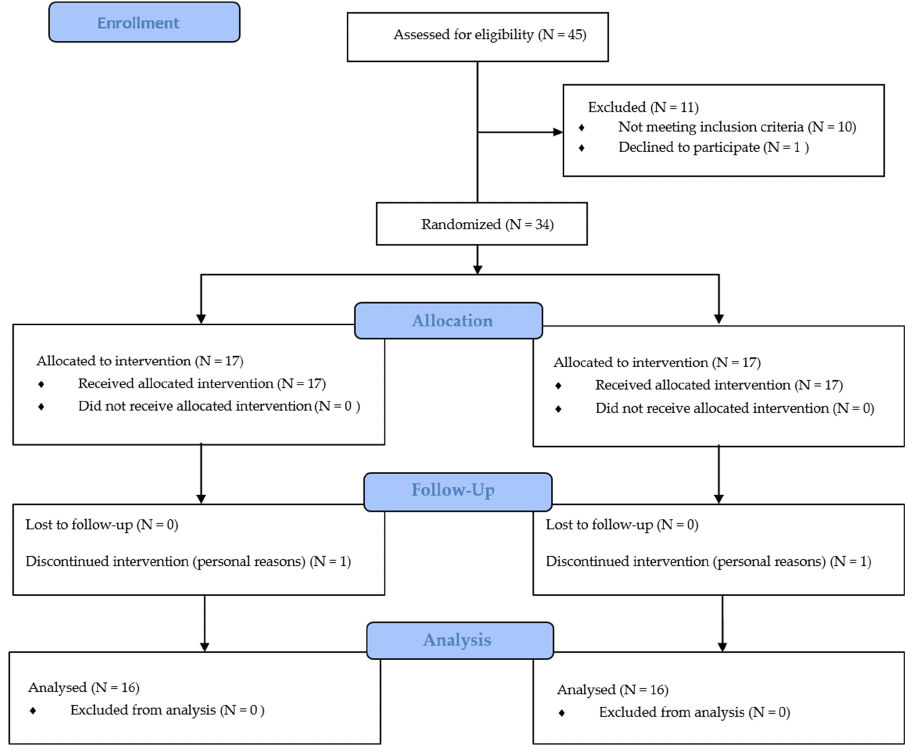
Figure 2. Consolidated Standards of Reporting Trials (CONSORT) flow diagram. This figure